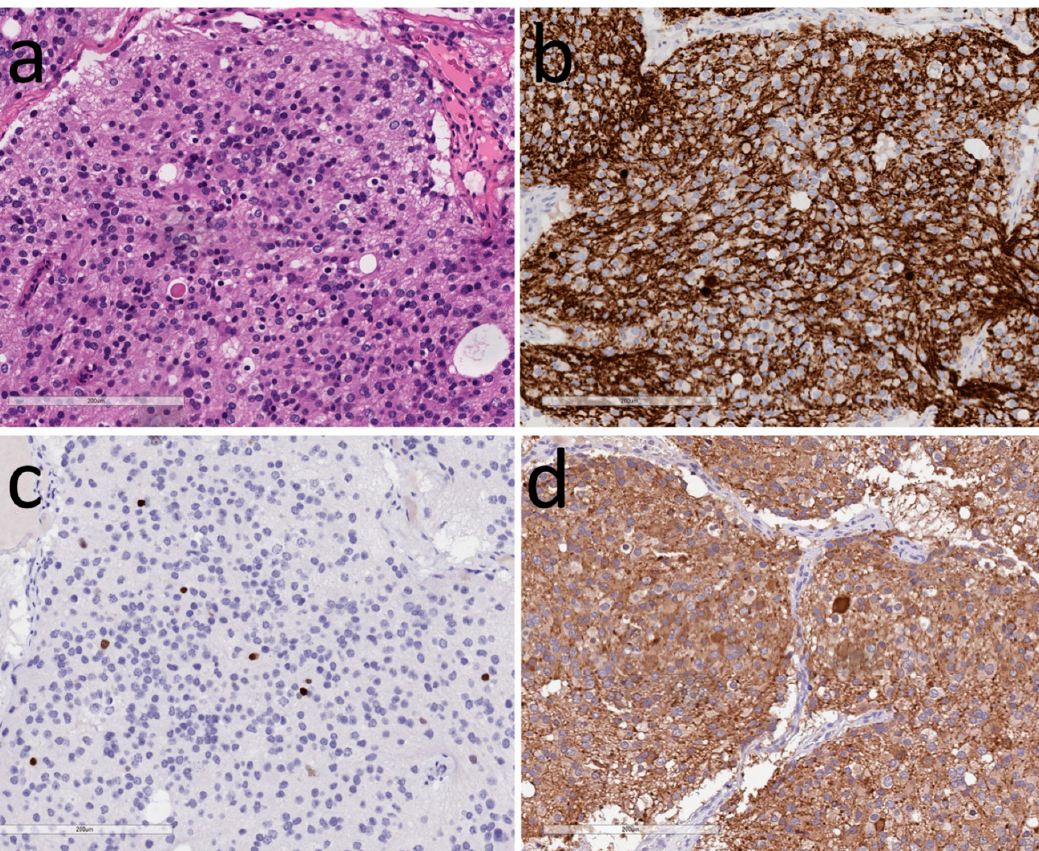
Figure 2. Hypothalamic neurocytoma. ( a ) H&E identifies small round cells in abundant neuropil with a dilated neuronal axon resembling a Herring body; ( b ) Neurofilament highlights the neurons and neuropil; ( c ) TTF1 decorates some of the neurons; ( d ) Vasopressin is expressed by the tumor cells and highlights an axonal terminal known as a Herring body.